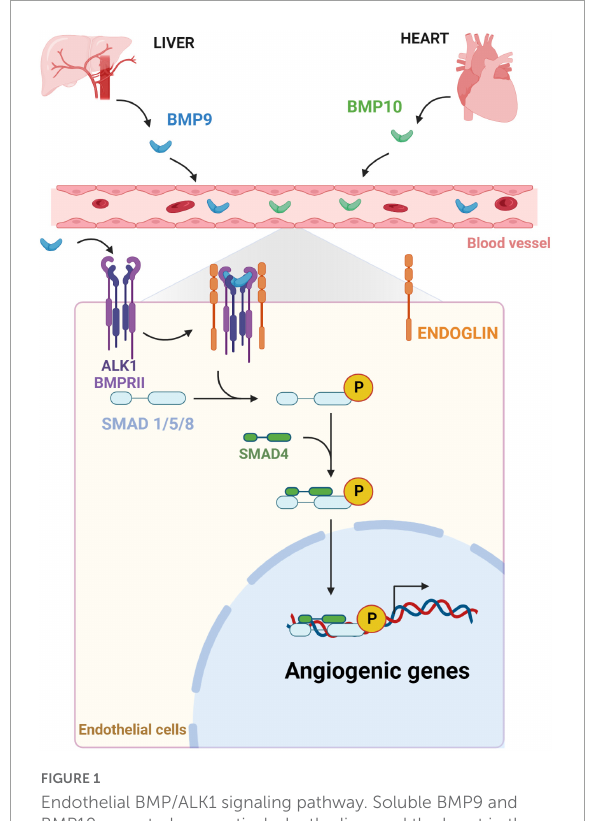
FIGURE1 Endothelial BMP/ALK1 signaling pathway. Soluble BMP9 and BMP10, secreted, respectively, by the liver and the heart in the bloodstream, bind their receptor ALK1, a SER/THR kinase, and its coreceptors BMPRII and ENDOGLIN at the surface of ECs. The activation of the BMP receptor complex will trigger the downstream SMAD signaling. Phosphorylated SMAD1/5/8 will recruit SMAD4. This SMAD complex accumulates in nucleus to regulate transcription of target genes, including genes involved in angiogenic